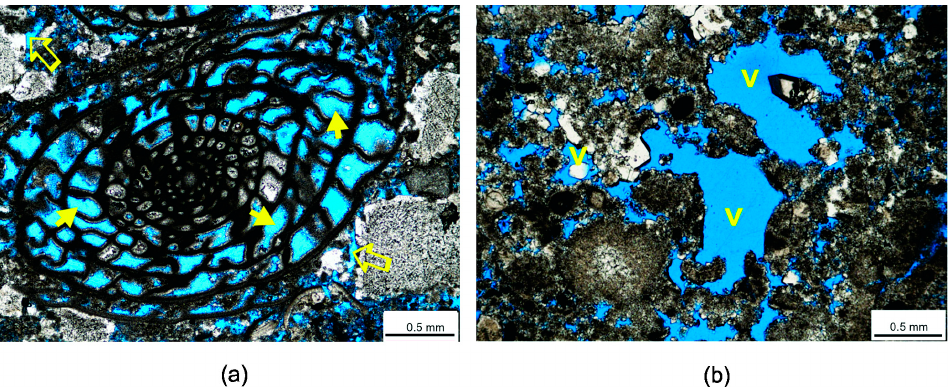
Figure 21. Photomicrographs of core samples showing ( a ) intragranular pores (solid yellow arrow) within fusulinids and minor intergranular pores (hollow arrow) at depth of 5329 ft (1624.2 m) in well 9. ( b ) Abundant vugs (v) in well 10 at depth of 5215.9 ft (1589.7 m) (Fu and Ambrose, 2020, reproduced with permission of GCAGS).